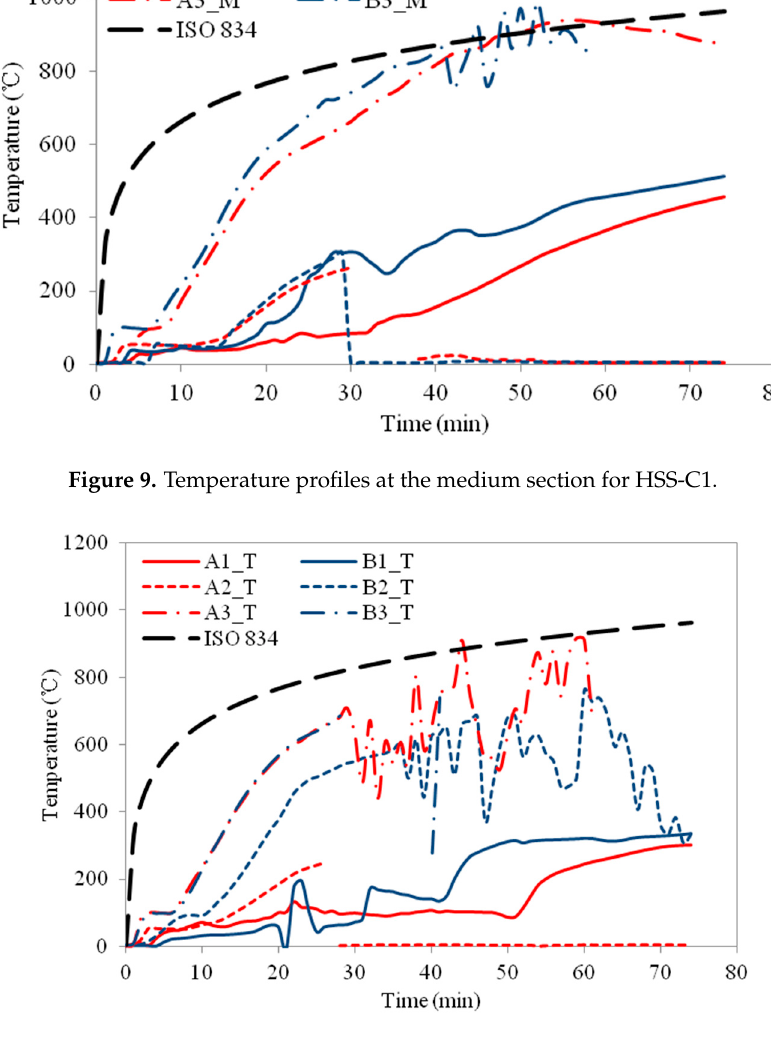
Figure 11. Temperature profiles at the medium section for HSS-C2. Figure 12. Temperature profiles at the top section for HSS-C2.